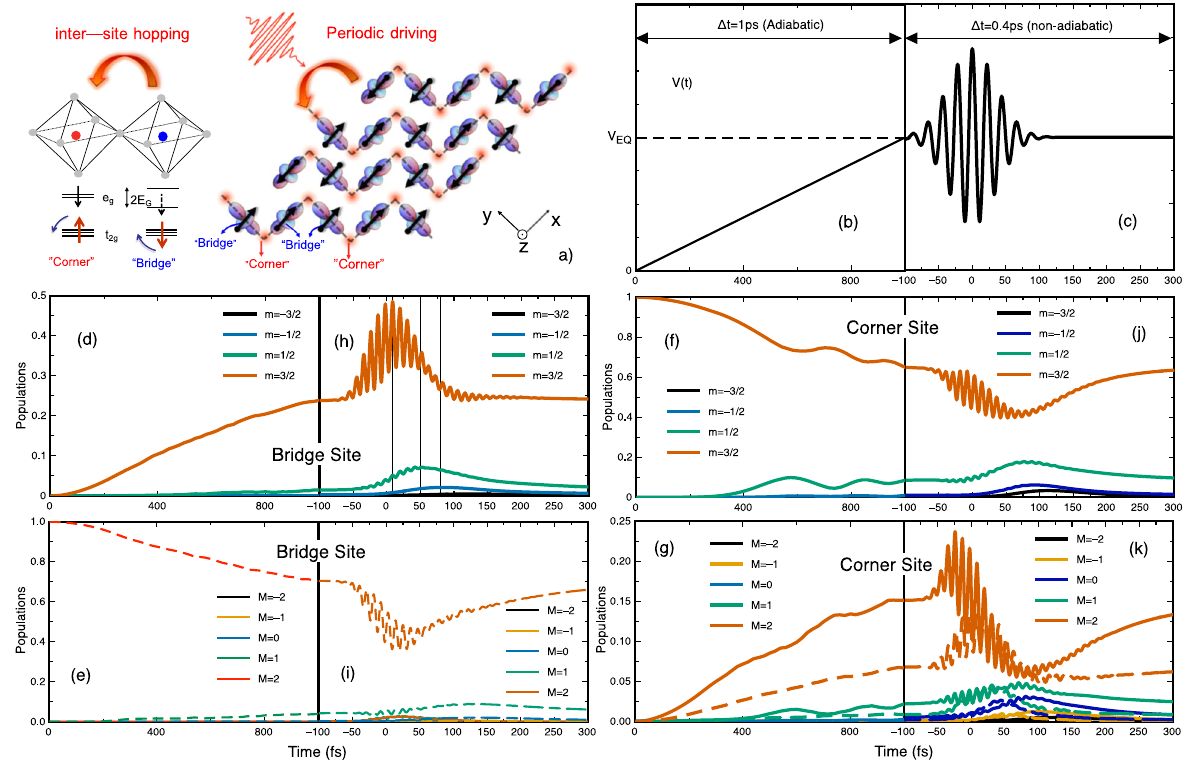
Fig. 1 Time evolution of an antiferromagnetic state driven by time-periodic ultra-short modulation of the intersite hopping amplitudes V ( t ). a Schematic of the antiferromagnetic con fi guration used in our numerical calculation. The complex unit cell consists of zig-zag ferromagnetic chains with interchanging corners (red circle) and bridge (blue circle) lattice sites. Neighboring chains are antiferromagnetically coupled in the plane and stacked in antiferromagnetically coupled identical planes along the z -axis. Red arrows indicate the electronic hopping between antiferromagnetic sites that triggers the spin quantum dynamics of main interest. Time evolution is induced by both adiabatic ( b ) and nonadiabatic ( c ) time modulation of the electronic hopping amplitudes V ( t ). The V ( t ) temporal pro fi le in c results from a few-cycle electric fi eld pulse with Rabi energy d R = eEa = 100 meV and duration t p = 100 fs. The latter drives nonthermal populations of different spin and charge local con fi gurations at the “ bridge ” ( Q B ≠ 0, d , e , h , and i ) and “ corner ” ( Q C = 0, f , g , j , and k ) lattice sites. d – g , h – k show the time-dependent populations driven by adiabatic ( b ) and nonadiabatic ( c ) coherent hopping modulation, respectively. Vertical lines in h indicate the time delay in the development of different spin state populations during the nonadiabatic light-wave-driven time